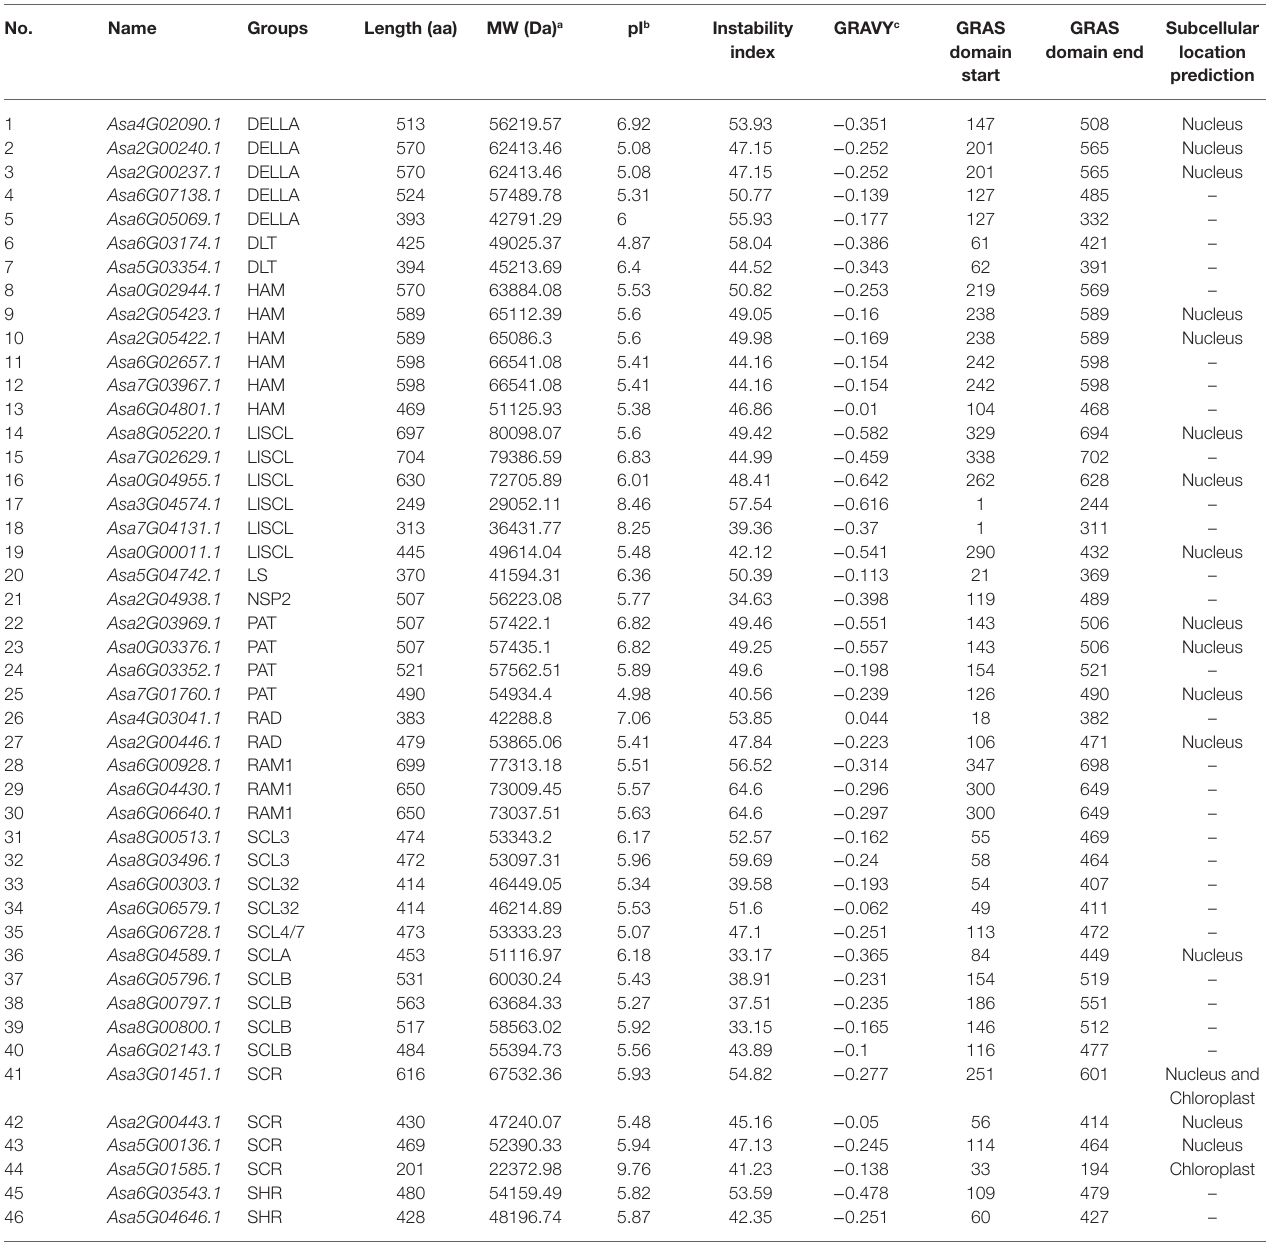
TABLE 1 | List of gene IDs and characteristics of the 46 AsGRAS